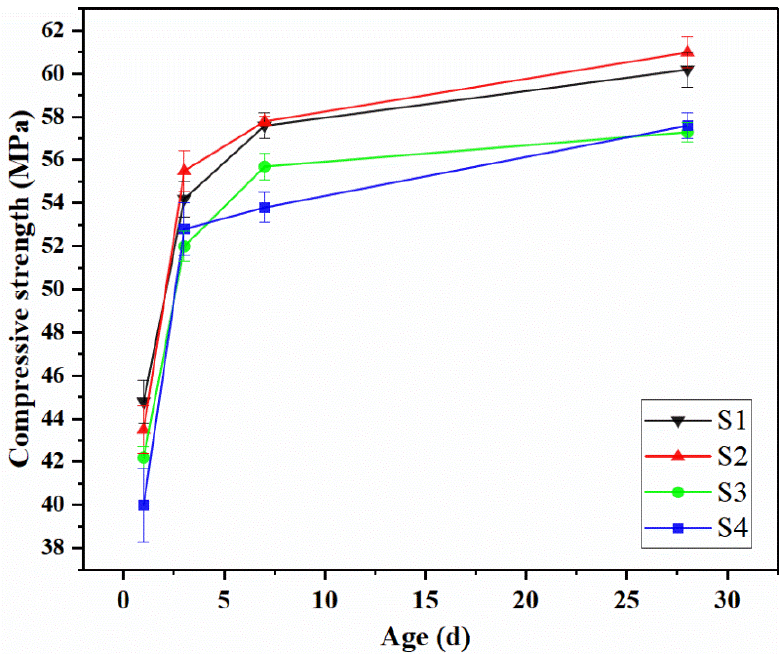
Figure 7. Compressive strength of cement with different proportions.